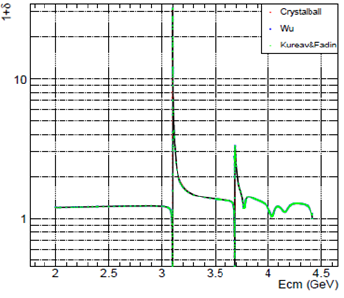
Figure 2. The ISR factors calculated by Crystalball scheme, Wu’s scheme and Kureav & Fadin